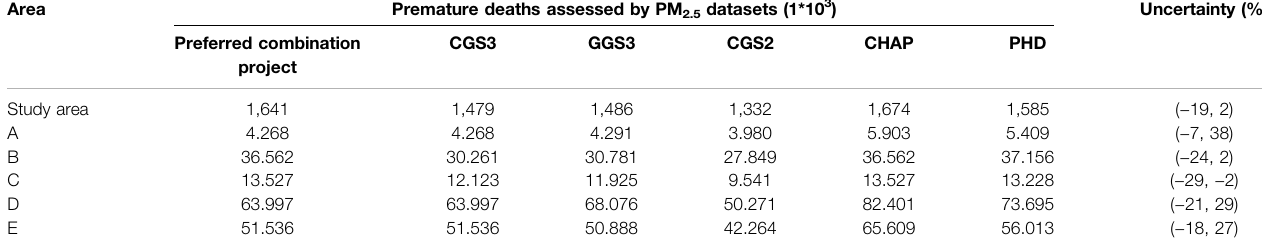
TABLE 3 | Uncertainty of the average premature deaths in 17 years in different